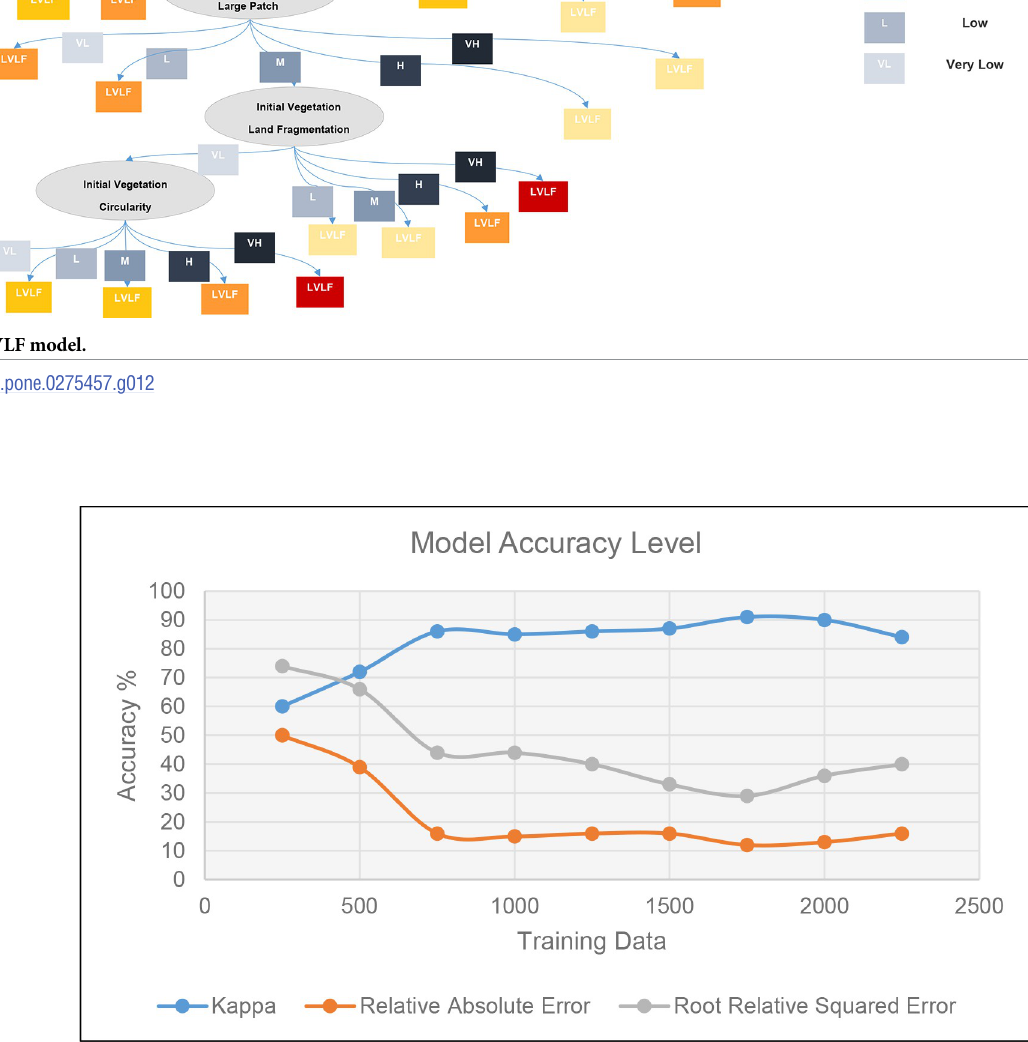
PLOS ONE | https://doi.org/10.1371/journal.pone.0275457 February 6,